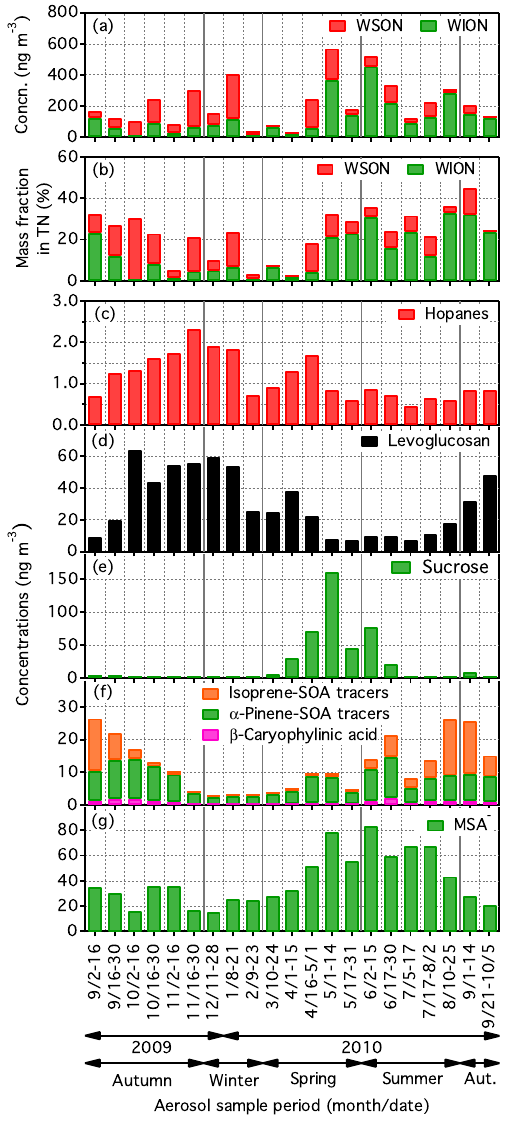
Figure 4. Seasonal variations in (a) concentrations of WSON and WION, (b) mass fractions of WSON and WION in TN, and (c) – (e) concentrations of organic molecular tracers and MSA − in Sapporo aerosols. Concentrations of hopanes are the sum of the concentrations of C 27 –C 32 hopanoid hy- drocarbons. Concentrations of isoprene-SOA tracers are the sum of the concentrations of 2-methylglyceric acid, cis- 2-methyl-1,3,4-trihydroxy-1-butene, 3-methyl-2,3,4-trihydroxy-1- butene, trans-2-methyl-1,3,4-trihydroxy-1-butene, 2-methylthreitol and 2-methylerythritol, whereas concentrations of α -pinene-SOA tracers are the sum of the concentrations of 3-hydroxyglutaric, pinonic, pinic and 3-methyl-1,2,3-butanetricarboxylic acids. The data of organic molecular tracers are from Pavuluri et al. (2013) and MSA − is from Pavuluri et al.